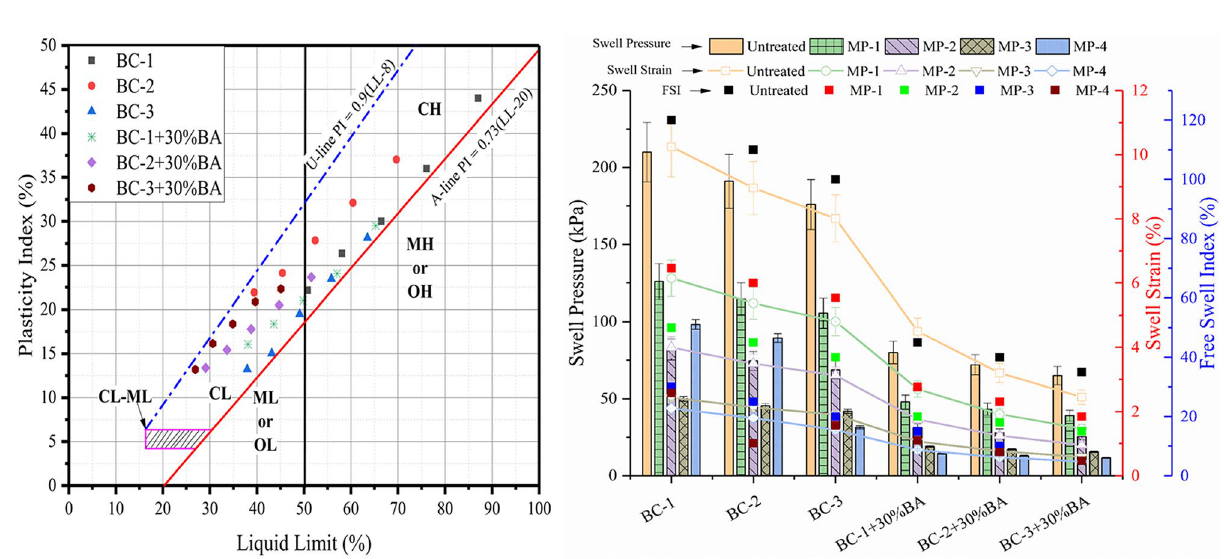
Figure 2. Effect of biostimulated MICP treatment on plasticity and swell properties of the expansive